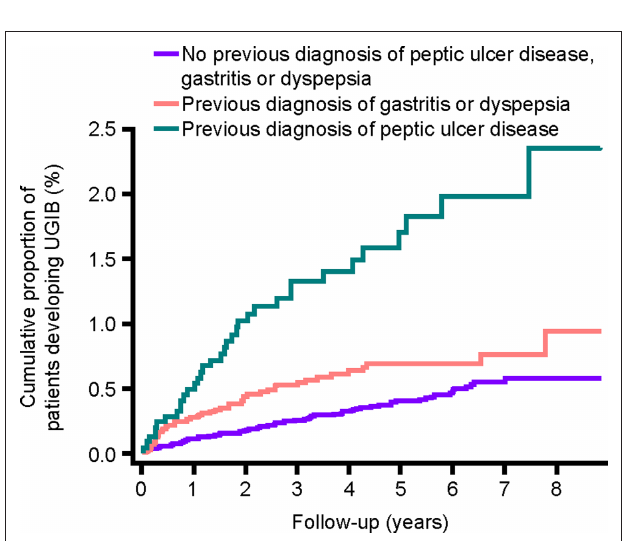
Figure 6 | Cumulative proportion of patients developing ugiB, stratified by history of peptic ulcer disease or gastritis/dyspepsia. UGIB, upper gastrointestinal